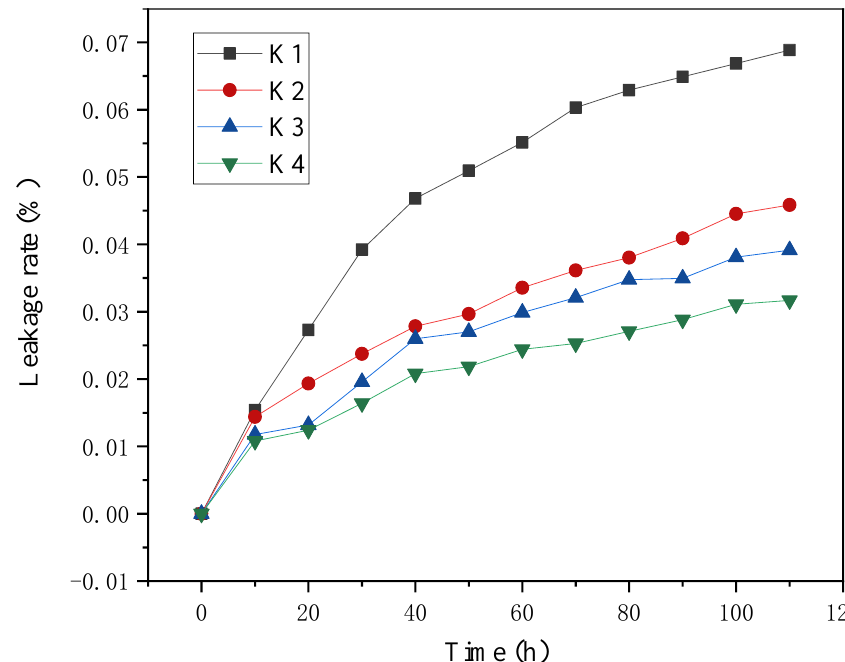
Figure 3. The leakage rate curve diagram.